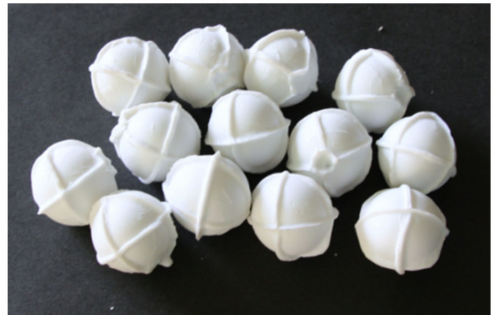
Figure 15. Ceramic